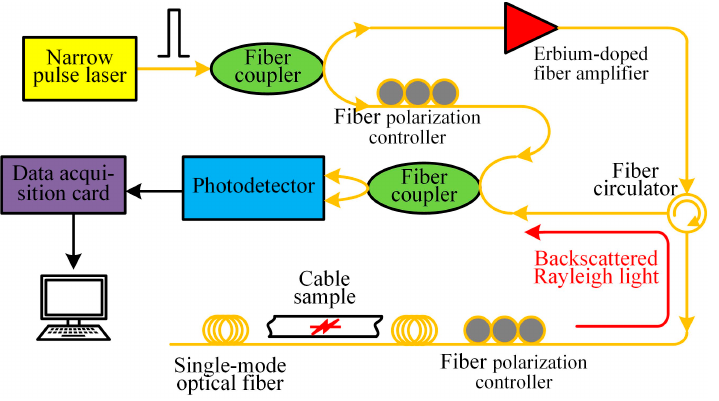
Figure 1. Schematic diagram of cable-PD-monitoring experiment based on optical-fiber vibration sensing.